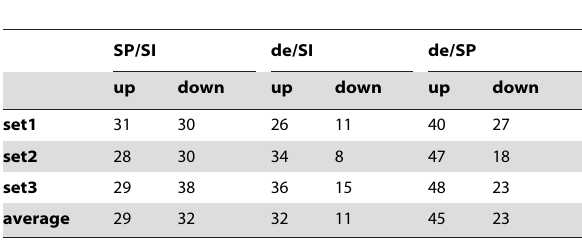
Table 2. Summary of differentially expressed proteins identified in SP/SI, de/SI and de/SP among the three